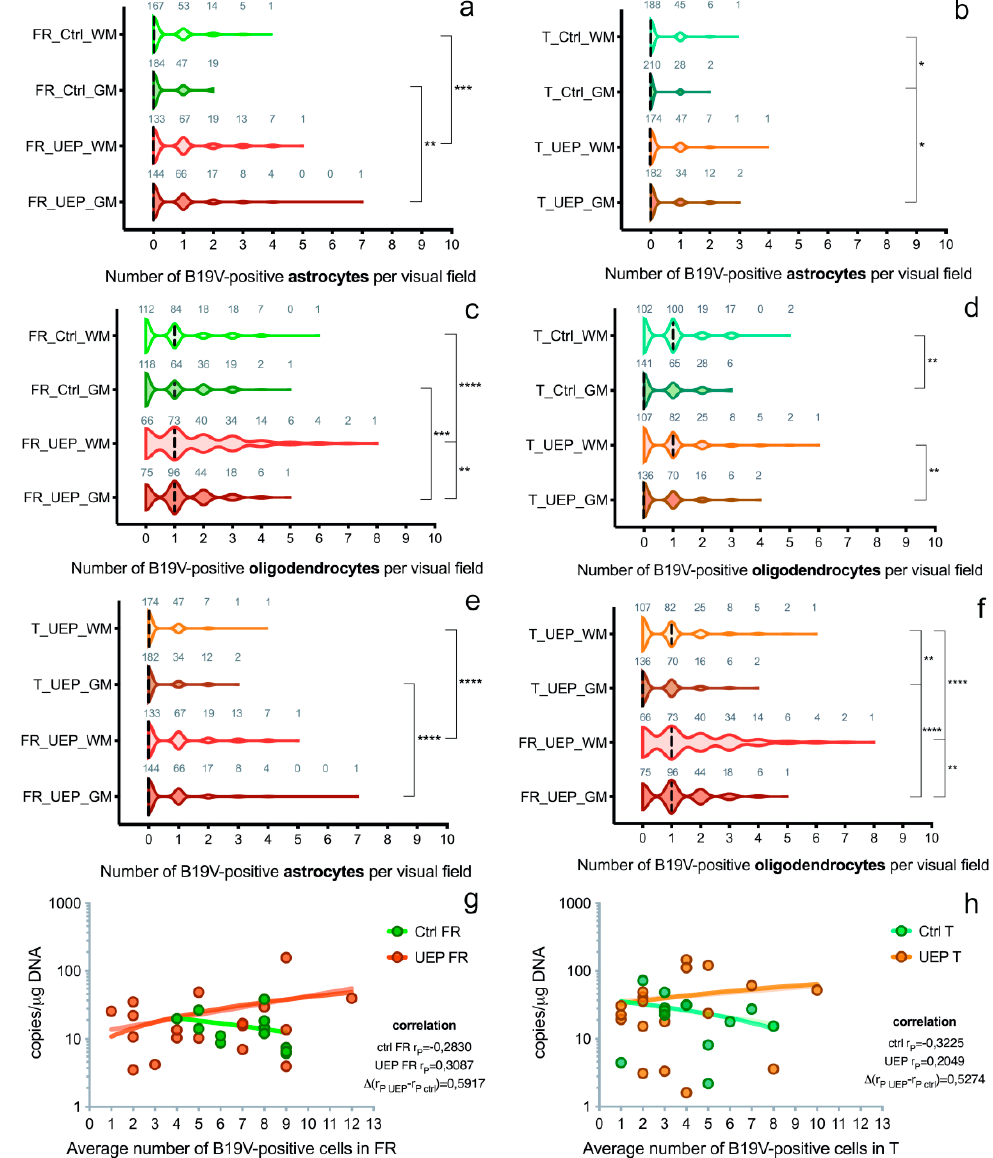
Figure 2. Data representing brain tissue analysis: ( a ) Distribution of B19V-positive astrocytes per visual fields in the gray (GM) and white matter (WM) of the UEP group and controls (Ctrl), frontal lobe (FR); ( b ) Distribution of B19V-positive astrocytes per visual fields in the gray (GM) and white matter (WM) of the UEP group and controls (Ctrl), temporal lobe (T); ( c ) Distribution of B19V-positive oligodendrocytes per visual fields in the gray (GM) and white matter (WM) of the UEP group and controls (Ctrl), frontal lobe (FR); ( d ) Distribution of B19V-positive oligodendrocytes per visual fields in the gray (GM) and white matter (WM) of the UEP group and controls (Ctrl), temporal lobe (T); ( e ) Distribution of B19V-positive astrocytes per visual fields in the gray (GM) and white matter (WM) of the UEP group, frontal lobe (FR), temporal lobe (T); ( f ) Distribution of B19V-positive oligodendrocytes per visual fields in the gray (GM) and white matter (WM) of the UEP group, frontal lobe (FR), temporal lobe (T); ( g ) Correlation of qPCR ( y -axis) and IHC ( x -axis) data in the frontal lobe (FR) tissue samples, comparison of regression slopes of the control and UEP groups; ( h ) Correlation of qPCR ( y -axis) and IHC ( x -axis) data in the temporal lobe (T) tissue samples, comparison of regression slopes of the control and UEP groups. Violin plots: dashed lines represent the approximate ratio of visual fields (out of 240) with B19V-positive cells to fields with B19V-negative cells (“0”—ratio less than 1.0, “1”—more than 1.0); numbers in gray show visual fields; asterisks represent a significance level (* p < 0.05, ** p < 0.01, *** p < 0.001, **** p < 0.0001) of differences between groups (Kruskal–Wallis test followed by two-stage step-up method of Benjamini, Krieger, and Yekutieli as post hoc procedure).